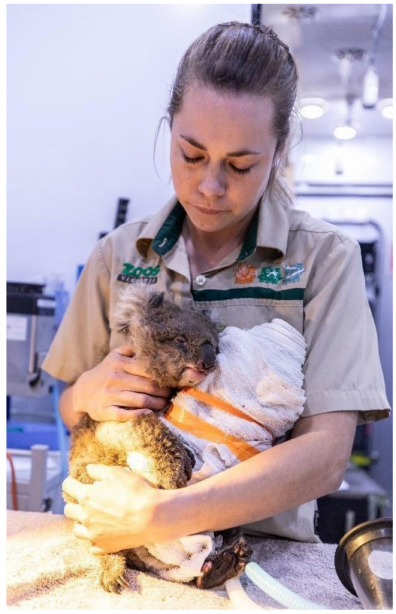
Figure A1. Koala assessment by Zoos Victoria staff (Marcia